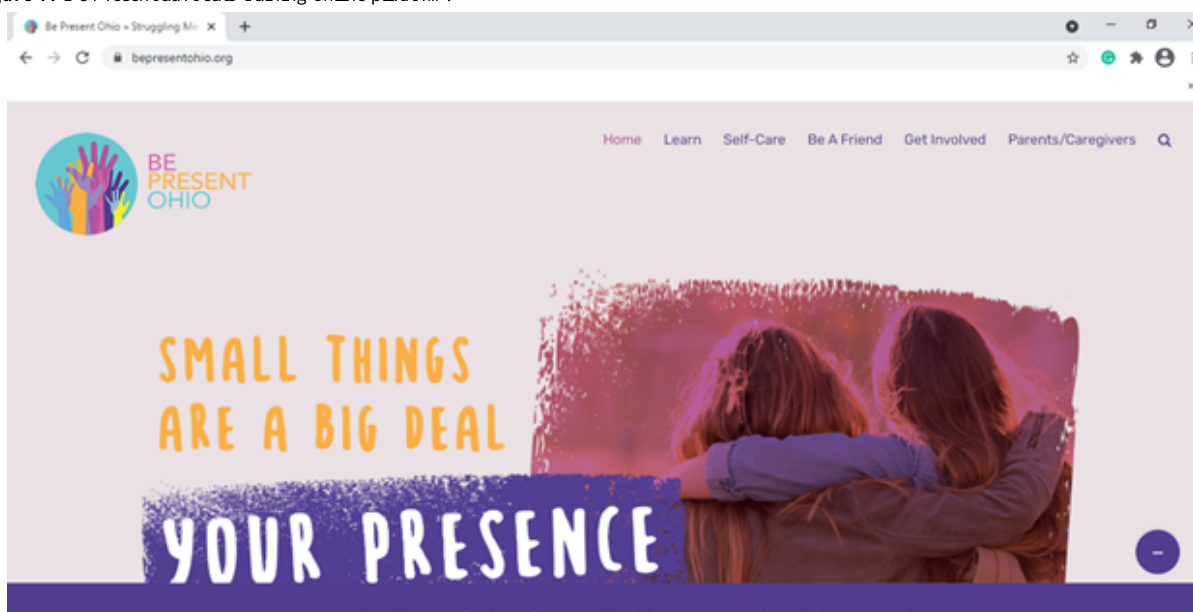
Figure 1. Be Present advocate training online